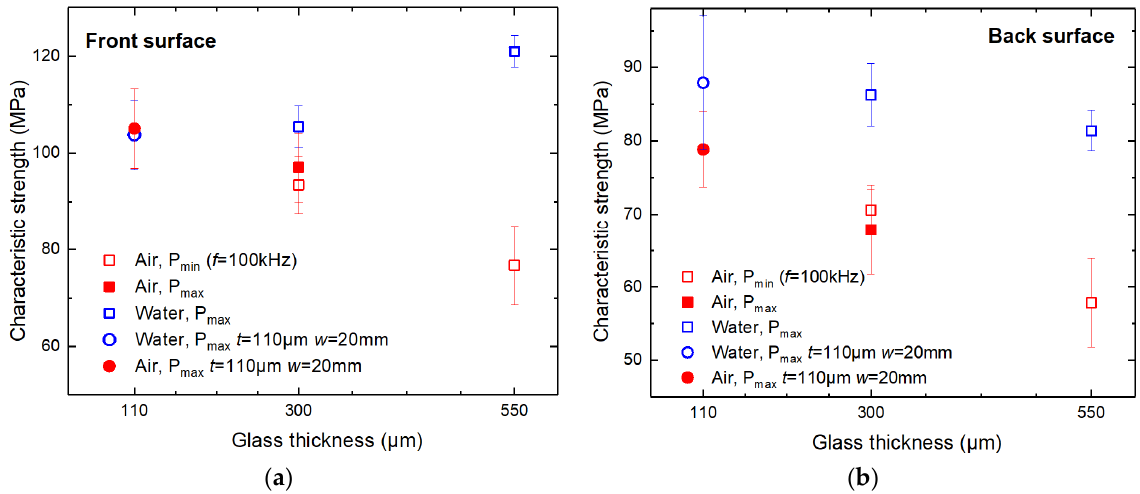
Figure 12 . Characteristic strength of laser-cut glass strips. The bending force was applied from the front ( a ) and back ( b ) sides. front ( a ) and back ( b )